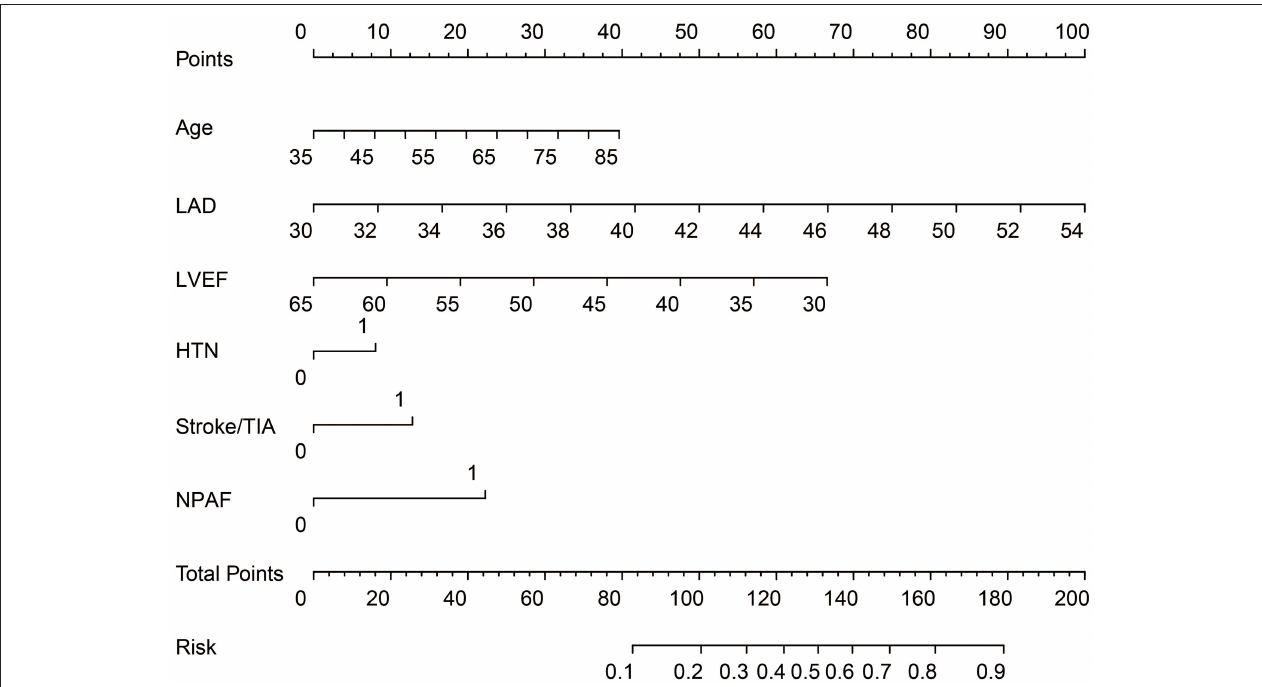
FIGURE 1 | Nomogram for peri-procedural estimation of LAT/SEC risk in NVAF patients. HTN, Hypertension; LAD, left atrium diameter; LVEF, left ventricular ejection fraction; NPAF, Non-paroxysmal